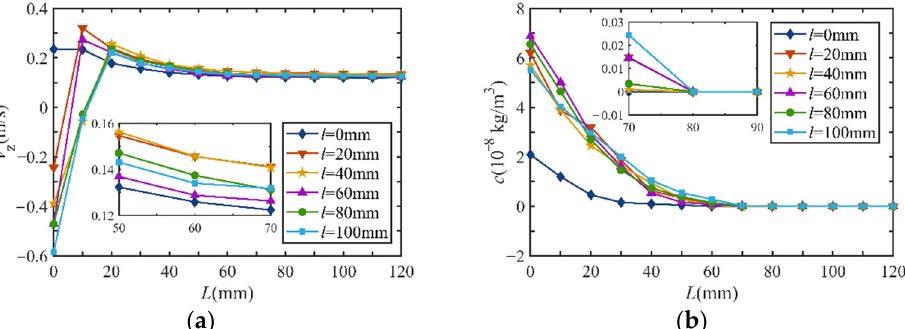
Figure 4. Variation curves of sealing indicators for the large-aperture channel with different l when v a = 1 m/s. ( a ) The v z variation curves with L for different l ; ( b ) the c variation curves with L for different l .